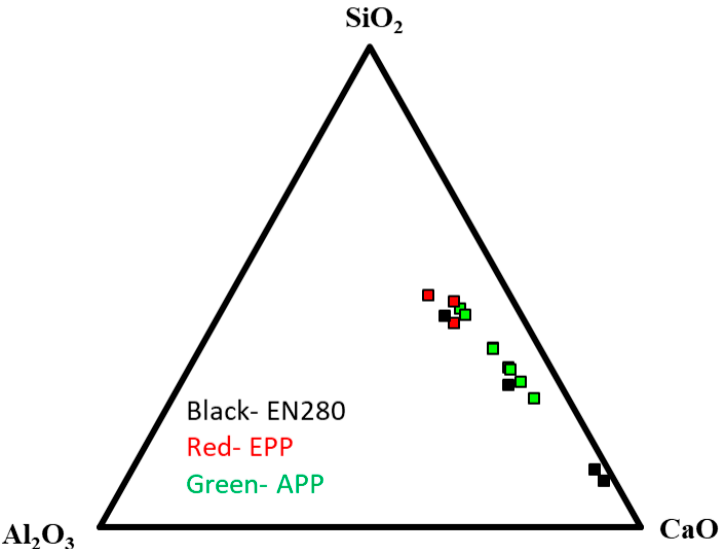
Figure 4. Ternary diagram of three major oxides in all OSAs.